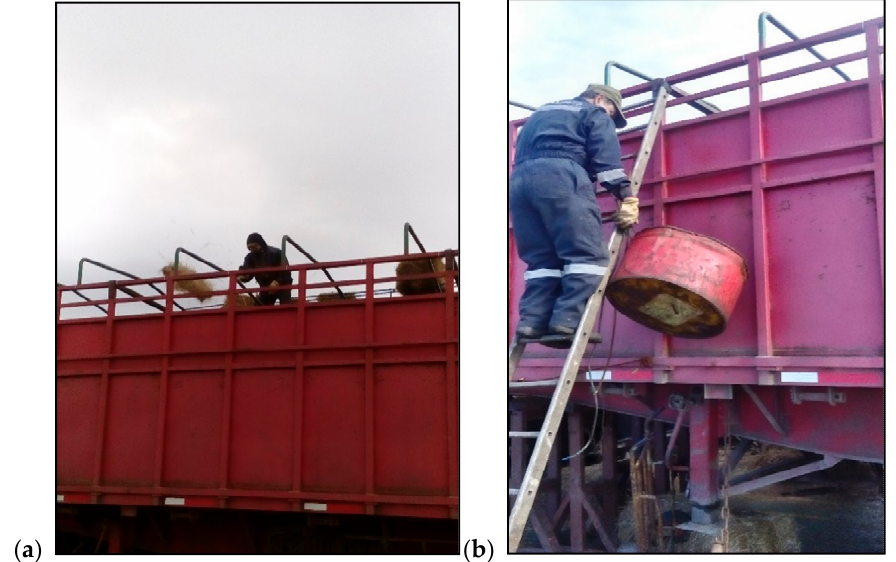
Figure 2. ( a ) Providing a bale of hay; ( b ) half of a barrel for watering a pen of cattle during sea